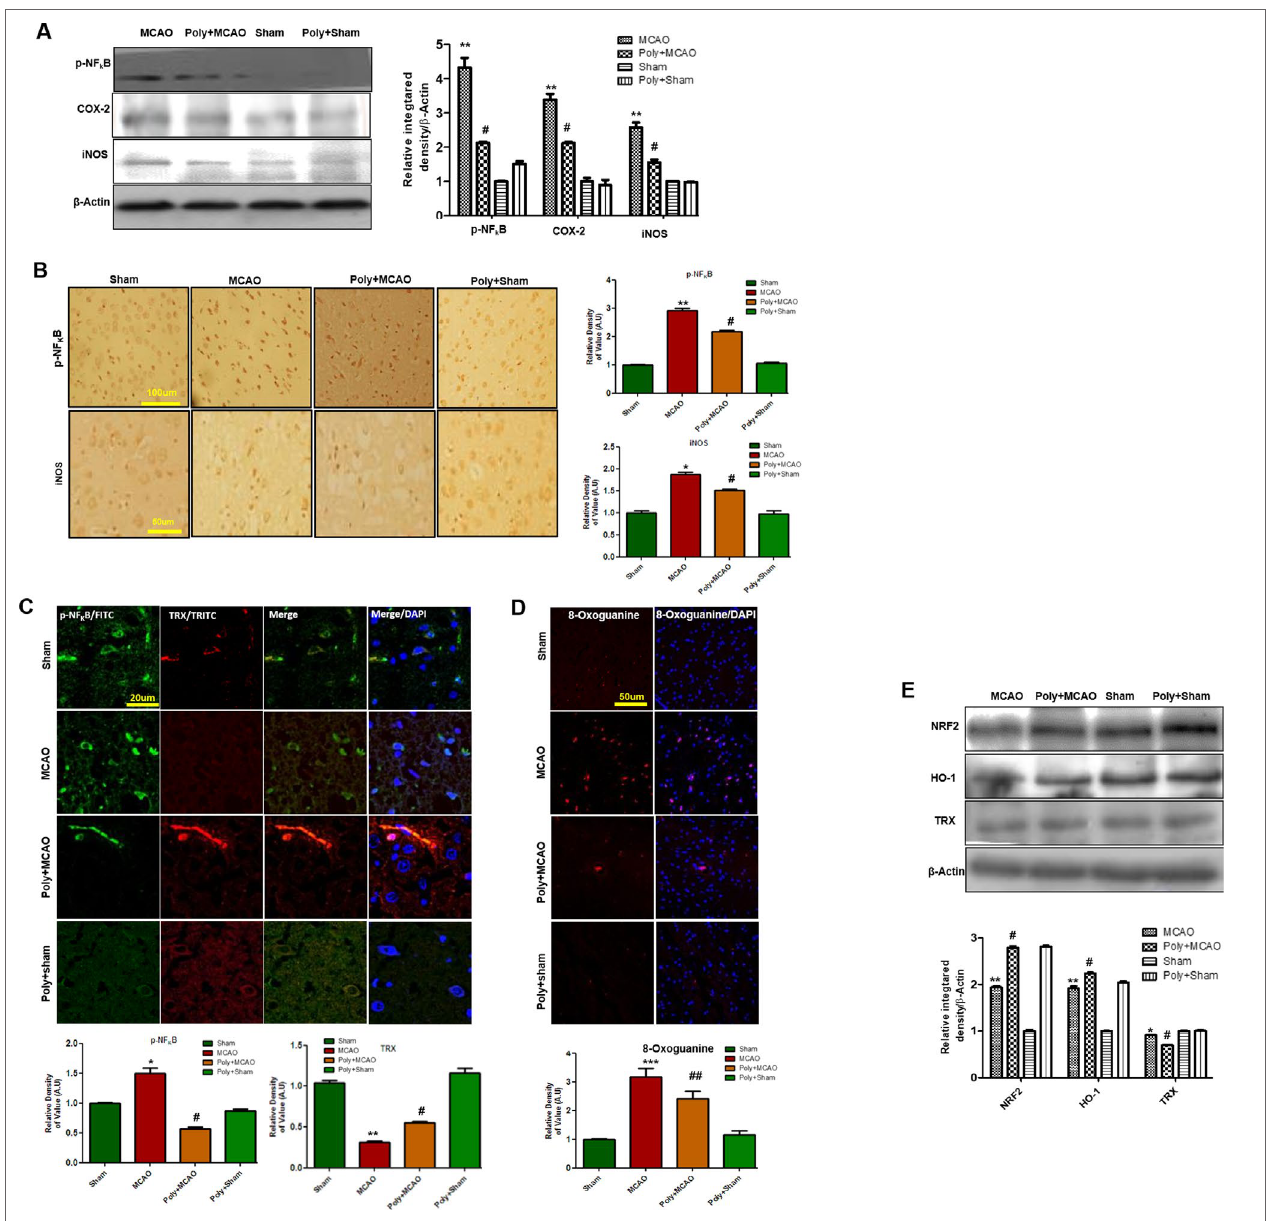
FIGURE 4 | Effect of polydatin on oxidative stress. (A) Western blot analysis of COX2, iNOS, and p-NF- κ B (n = 5–8/group). The protein bands were quantified using ImageJ and analyzed with GraphPad Prism 5 software. β -Actin was used as a control. Densitometric analysis was expressed in arbitrary units. (B) Representative photos of immunohistochemistry for p-NF- κ B and iNOS; scale bar = 50 µm. (C) Double immunofluorescence reactivity of p-NF- κ B and TRX. Scale bar = 20 μm and (n = 5–7/group). The ischemic tissue showed elevated expression of p-NF- κ B and attenuated expression of TRX after 24 h of continuous ischemia. p-NF- κ B and TRX were visualized by FITC and TRITC, respectively. (D) Representative immunofluorescence images of 8-oxoguanine staining (n = 5–7/group). Scale bar = 50 μm. (E) Polydatin treatment increased the levels of several antioxidant proteins in ischemic cortex. Western blot analysis of Nrf2, HO-1, and TRX (n = 5–8/group). The protein bands were quantified using ImageJ and analyzed by GraphPad Prism 5 software. β -Actin was used as a control. *** p < 0.001; ## , ** p < 0.01; # , * p <